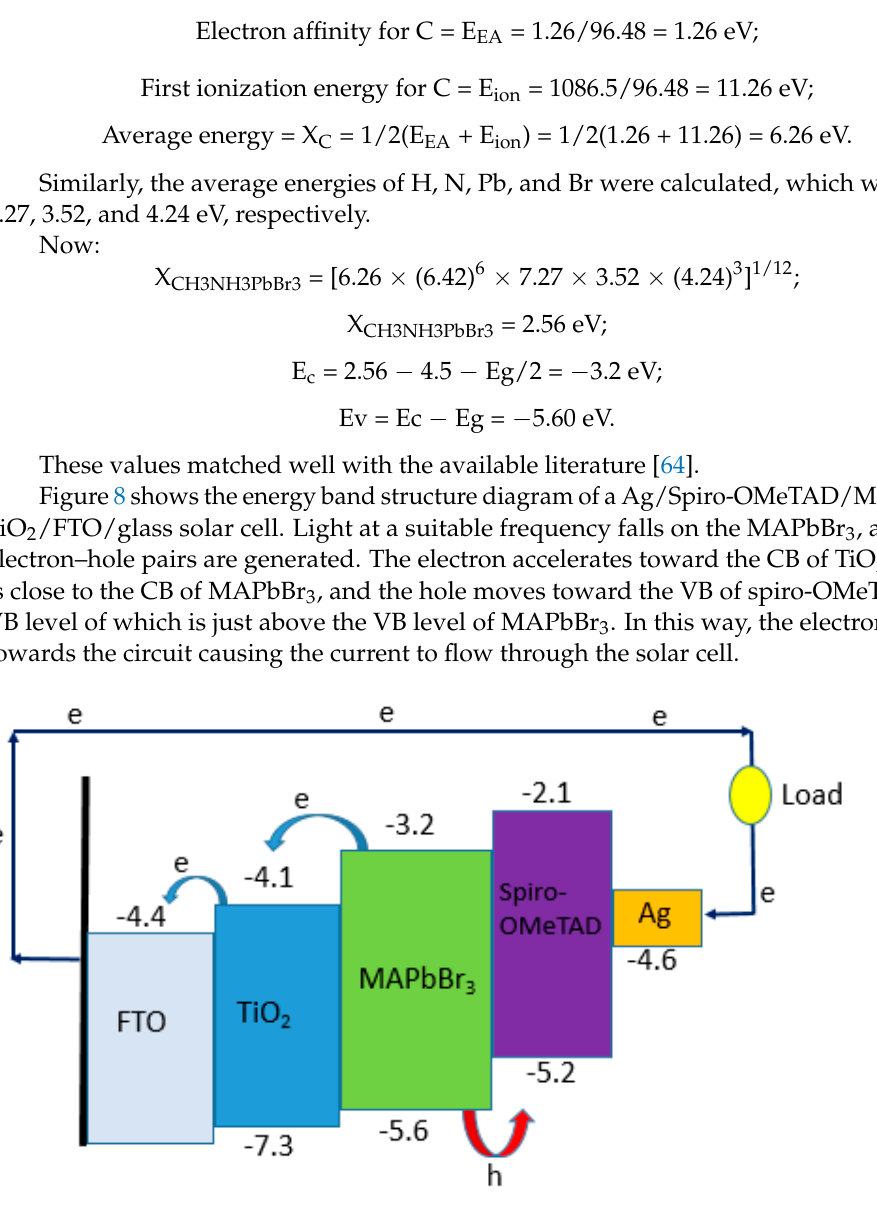
Figure 8. Band structure of a perovskite solar cell.